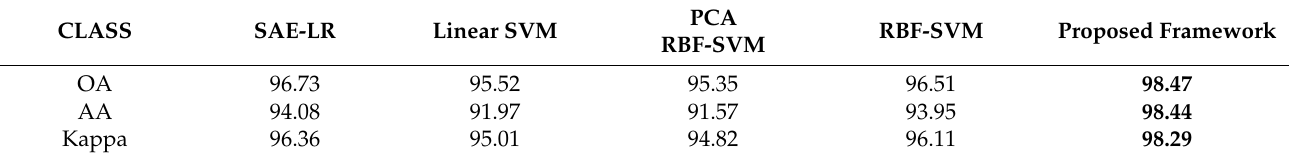
Table 5. Classification accuracy (%) for the Kennedy Space Center dataset via different algorithms.